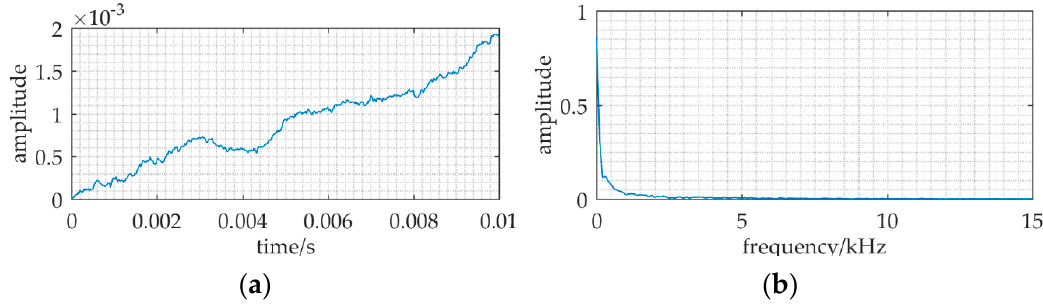
Figure 13. The result of MSR applied to the ULB signal detection when the sampling frequency is f s = 150 kHz, and the sampling data length is N = 1500. The carrier frequency is f c = 37.50001 kHz.